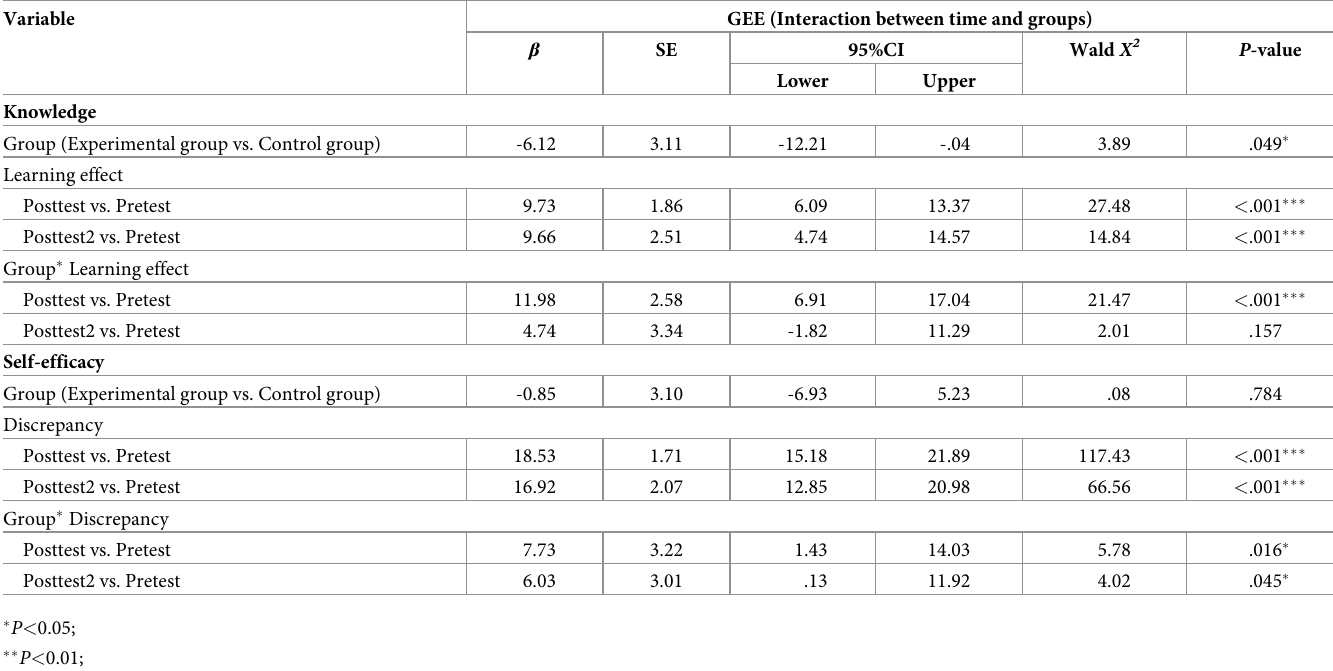
Table 3. The learning effectiveness in evidence-based knowledge and self-efficacy in practice between two groups over times.